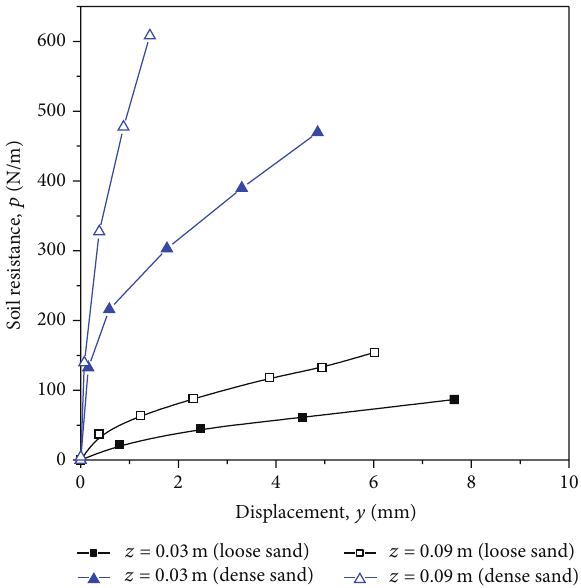
Figure 6: Comparison of p-y curves in loose and dense sand.